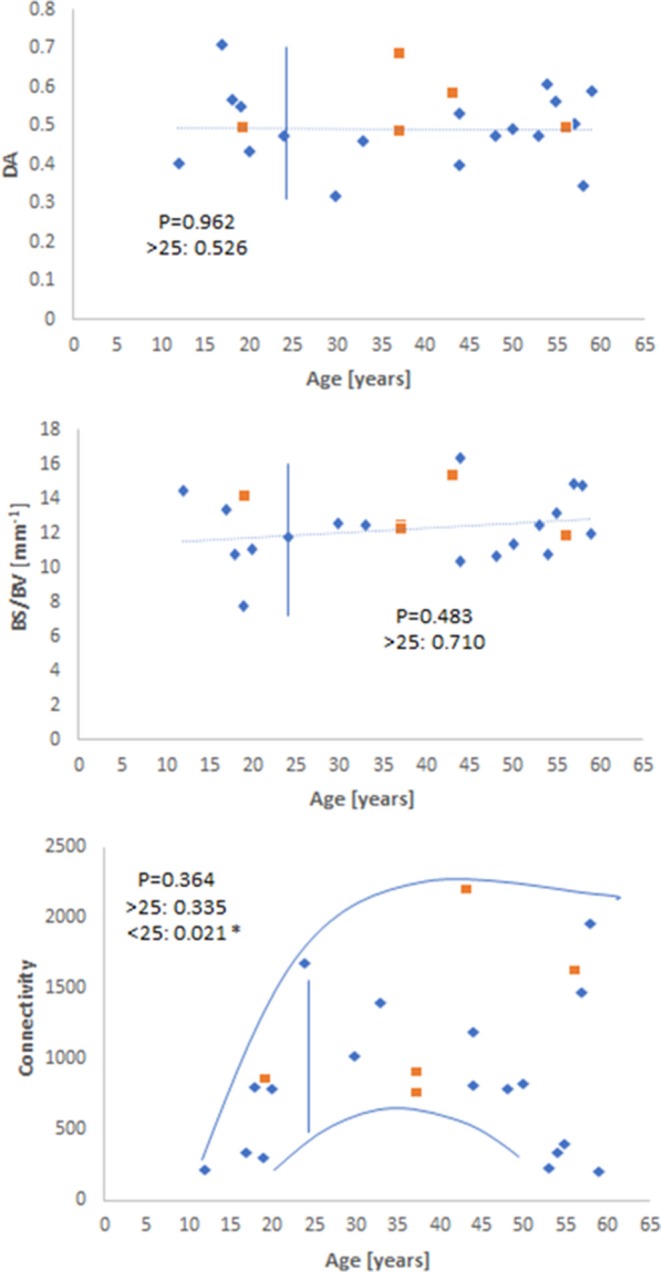
Scatterplot depicting the lack of change for DA and BS/BV as a function of age, in contrast to connectivity which exhibits two-phase behavior before- (significant increase with age) and after- skeletal maturity (slow decline with considerable value scatter) (Blue diamonds—males; orange squares—females).